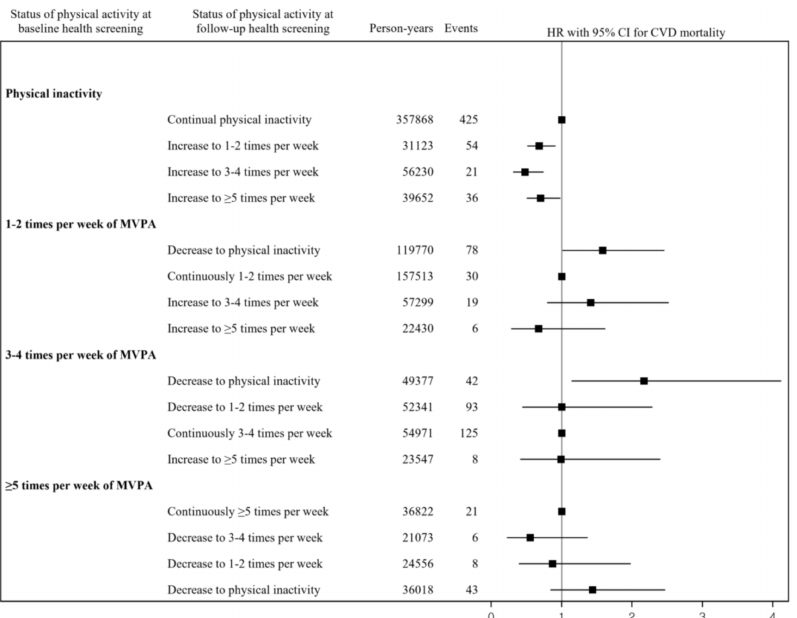
Figure 2. Relationship between changes in the frequency of MVPA and the subsequent risks of all-cause mortality. Note. HR, hazard ratio; CI, confidence interval; MVPA, moderate to vigorous physical activity; CVD, cardiovascular disease. HRs and 95% CIs were estimated after adjusting for sex, age, body mass index, systolic blood pressure, diastolic blood pressure, serum glucose, total cholesterol, alcohol consumption, cigarette smoking status, household income, location of residence, disability, and comorbidities.